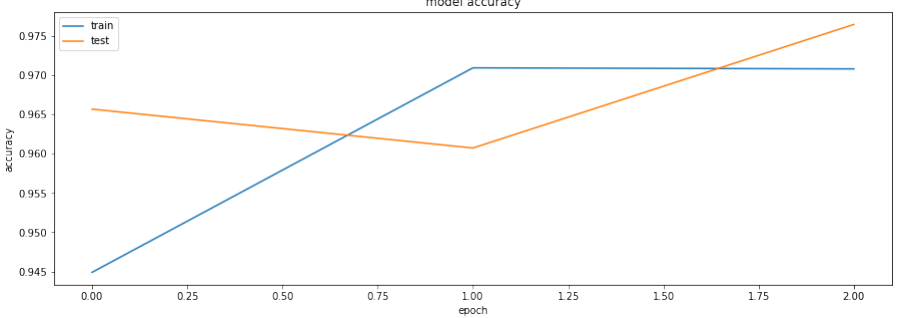
Figure 6. Model accuracy.